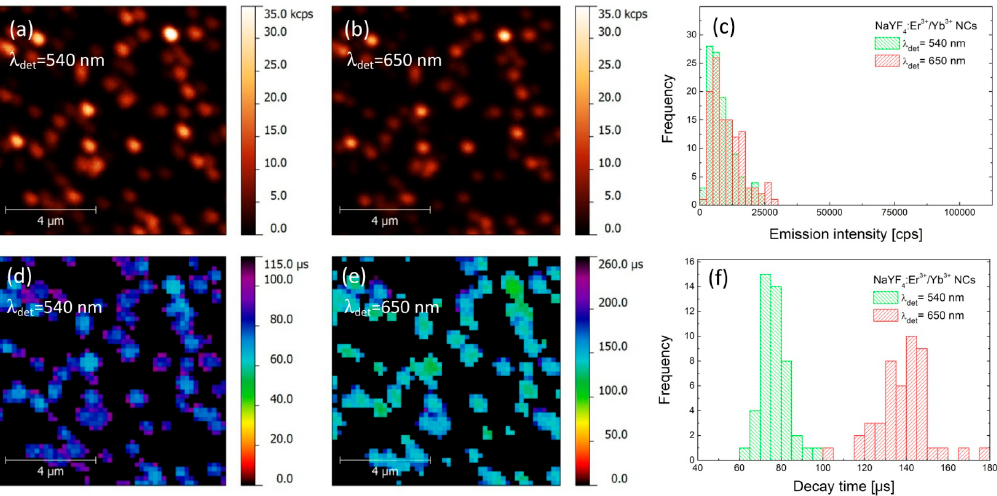
Figure 2. Photoluminescence intensity maps of α -NaYF 4 :Er 3+ /Yb 3+ nanocrystals (reference sample) observed at 540 nm ( a ) and 650 nm ( b ), together with statistical distributions of luminescence intensities ( c ). FLIM images of green and red emissions are presented in sections ( d , e ), respectively, together with statistical distributions of decay times shown in section ( f ).